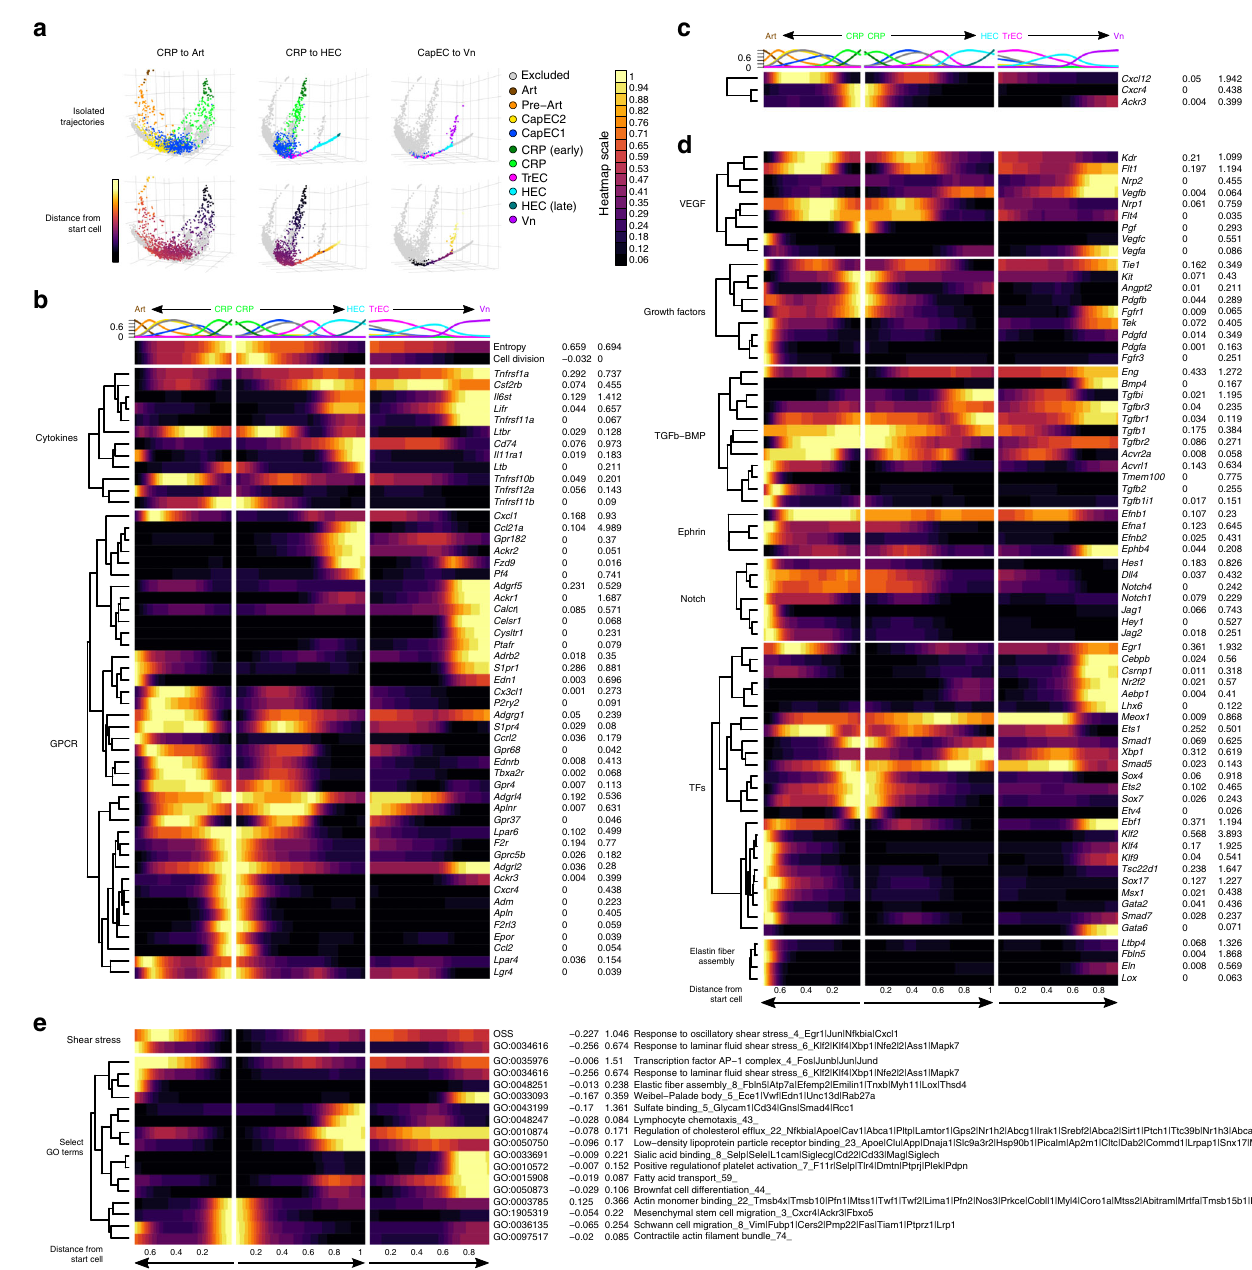
Fig. 7 Trajectories align EC subsets and mechanisms of EC development and speci fi cation to the vasculature. a Cells along KNN-based trajectories were isolated (Methods). b – e Expression of selected genes and gene set enrichment scores along cell trajectories from mature CRP to Art (plotted leftward), and from CRP to HEC or Vn (rightward). Cells along the trajectories were manually gated in the fi rst fi ve principal components of trajectory space and aligned according to distance from early CRP. Representation of cell types along the trajectories is indicated at top. Normalized count data plotted as a function of trajectory distance was smoothed using a gaussian kernel. Trajectory distances were scaled to the longest trajectory (CRP to HEC). Genes were grouped according to biological class or function. Imputed gene expression values for all cells (without duplications) were calculated independently and used for hierarchical clustering within each gene group. Cxcr4 , Cxcl12 , and Ackr3 are shown as a separate group at the top in c (see results). Average normalized expression values for the min and max subset are indicated to the right of each heatmap. OSS: pooled expression of oscillatory shear stress genes: Egr1 , Nfkbia , Junb , Cxcl1 . Cell Division: pooled expression of cell-cycle genes 74